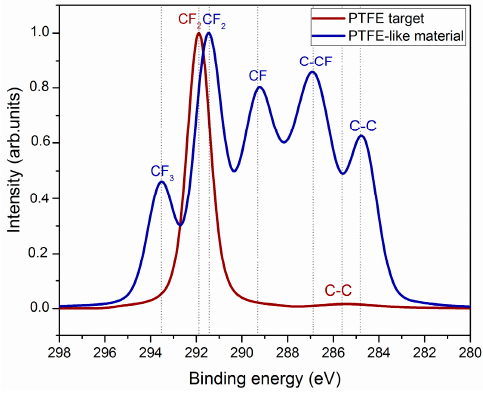
Figure 1. High-resolution spectra of C1s region for PTFE target ( red line ) and magnetron-sputtered PTFE material ( blue line ).